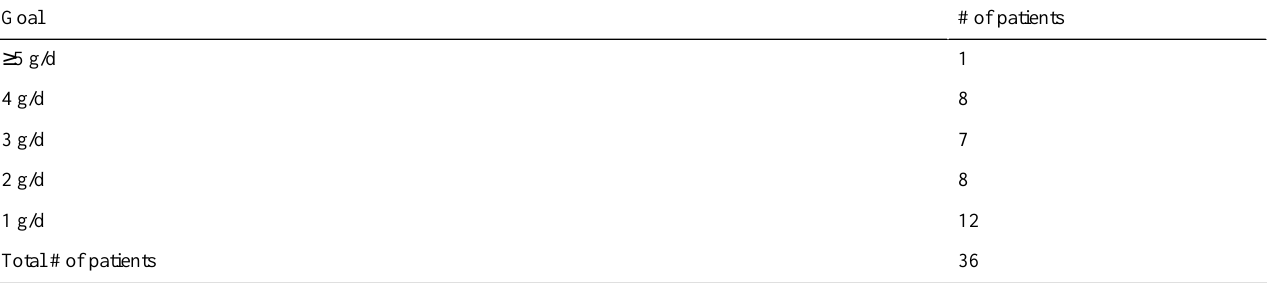
# of patientsGoal